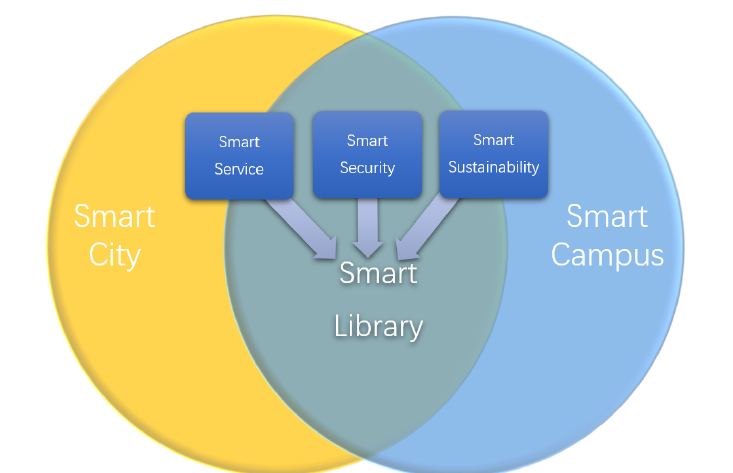
Figure 3. The relationship between smart city, smart library, and smart campus from the viewpoint of applying AI and